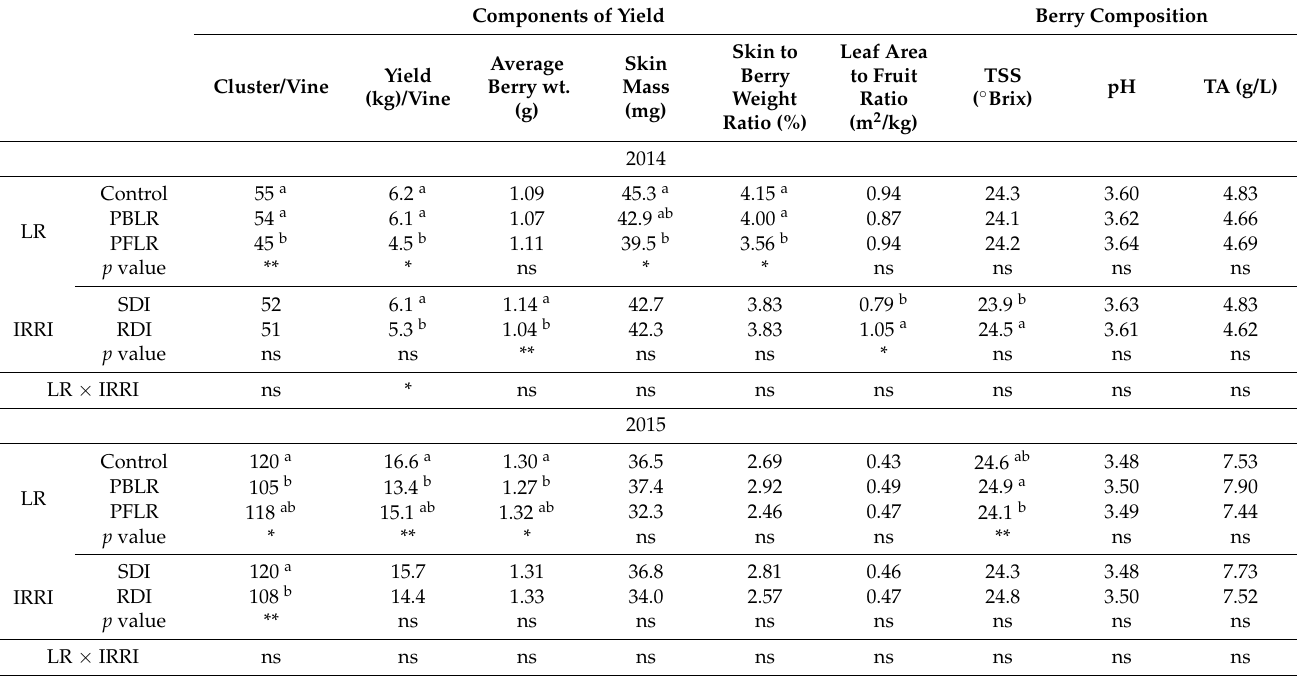
Table 2. Yield components and berry primary metabolites at harvest in a Merlot vineyard in Denair, California in 2015 a,b,c . Components of Yield Berry Composition Average Yield Cluster/Vine Berry wt. (kg)/Vine